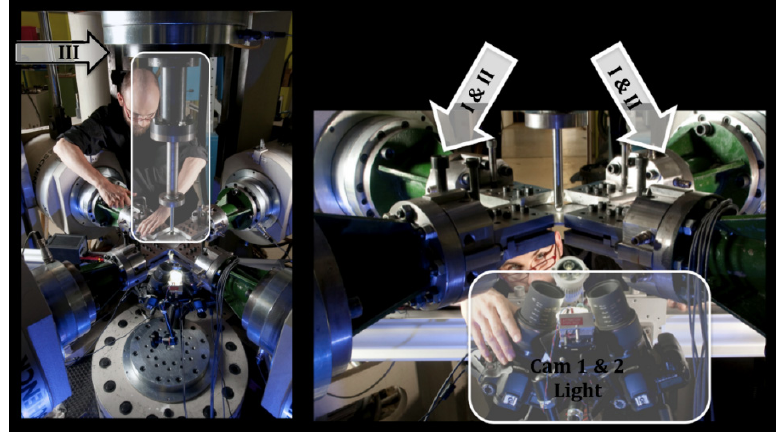
Figure 1: Six actuators servo-hydraulics testing machine ASTREE, experimental